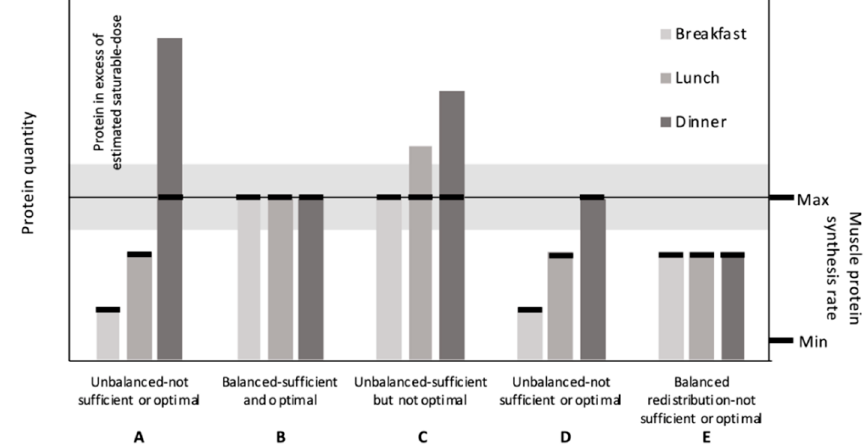
Figure 1. Theoretical relationship between protein quantity within meals and muscle protein synthesis (MPS) rates. ( A ) An example of an unbalanced protein distribution observed in the US. Exceeds the saturable dose limit for protein at one meal. ( B ) An “optimal” protein distribution; 1. provides sufficient protein per meal to maximize MPS without 2. exceeding the saturable dose estimates. ( C ) An unbalanced, higher-protein diet that provides sufficient protein per meal to maximize MPS but greatly exceeds saturable dose estimates at two meals. ( D ) An unbalanced, lower-protein diet that provides only one meal with sufficient protein to maximize MPS. ( E ) A redistributed balanced lower-protein diet; this results in three meals with insufficient protein to maximize MPS. (expanded adaption from Paddon-Jones and Rassmussen Curr Opin Clin Nutr Metab Care 2009, 12: 86 – 90).